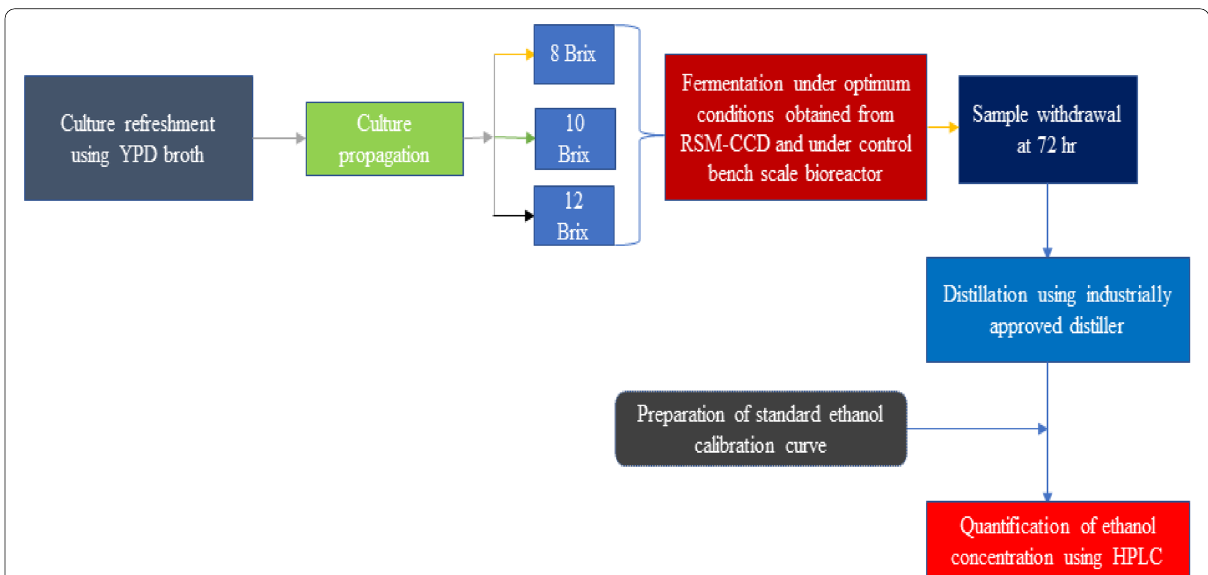
Fig. 8 Overveiw of complete set experiments under optimum fermentation conditions obtained from response surface methodology (RSM) based on the central composite design (CCD). Under these optimum condition, a bioethanol concentration 56 g.L − 1 and a bioethanol yield of 86% were